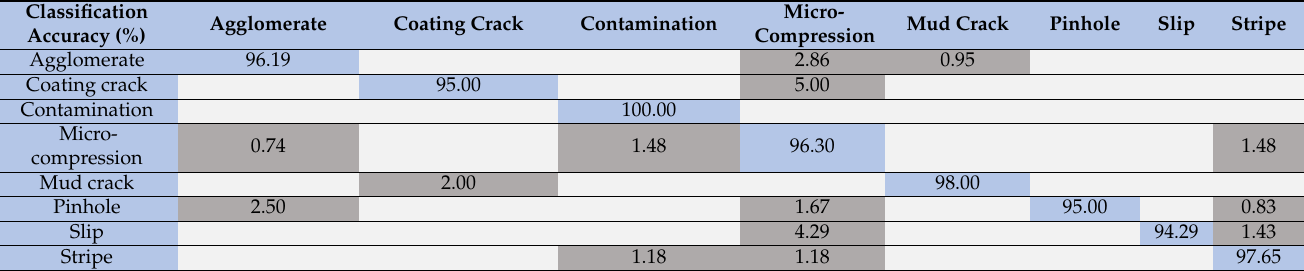
Table 4. Reclassification accuracy of taught defects (lines) by deep learning algorithm (lines add up to